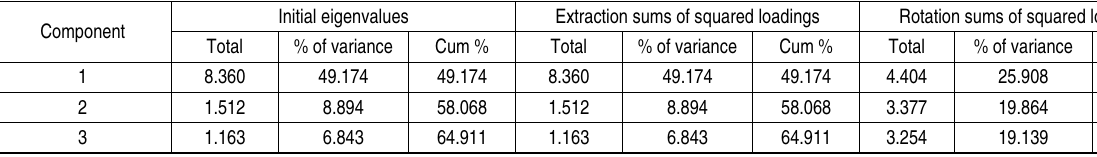
Table 2. Total variance job